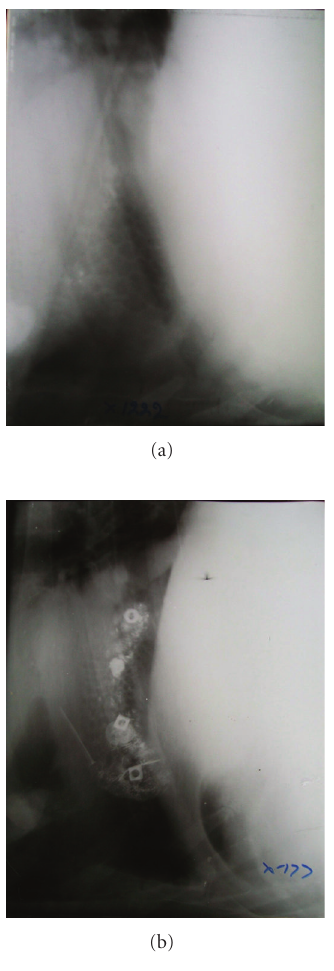
Figure 4: Lateral radiographs of reticulum showing honey comb reticular pattern of the sac-like structure in the thoracic cavity without (a) or with (b) metallic densities.